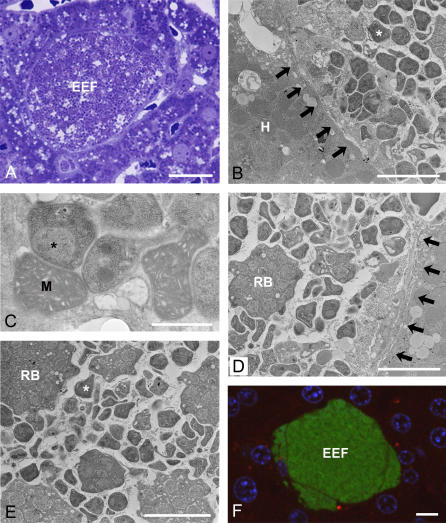
Characterization of Late P. yoelii EEFs(A) Semithin Epon section showing a mature EEF containing thousands of merozoites at 52 h after P. yoelii sporozoite infection. Note that few sinusoids are visible surrounding the EEF. Bar = 10 μm.(B) An infected hepatocyte containing a mixture of merozoites and host cell organelles indicating that the PVM has ruptured. The membrane of the infected cell is in close contact (arrows) with a neighboring hepatocyte. H, hepatocyte. *, merozoites. Bar = 5 μm.(C) Merozoites lie in close apposition to ultrastructurally well-preserved host cell mitochondria. M, mitochondria; *, merozoites. Bar = 1 μm.(D) EEF containing numerous merozoites and a few host cell organelles and remnant bodies. Note that one adjacent sinusoid has collapsed (arrows), while another contains an erythrocyte in its lumen indicating preserved blood flow. RB, remnant bodies. Bar = 5 μm.(E) Merozoites and remnant bodies of various shapes and sizes are embedded in a loose matrix. RB, remnant bodies; *, merozoites. Bar = 5 μm.(F) Intravital micrograph showing a mature PyGFP EEF at the onset of merosome formation. The nuclei of the host cell and the neighboring hepatocytes are visualized by Hoechst staining. Bar = 10 μm.